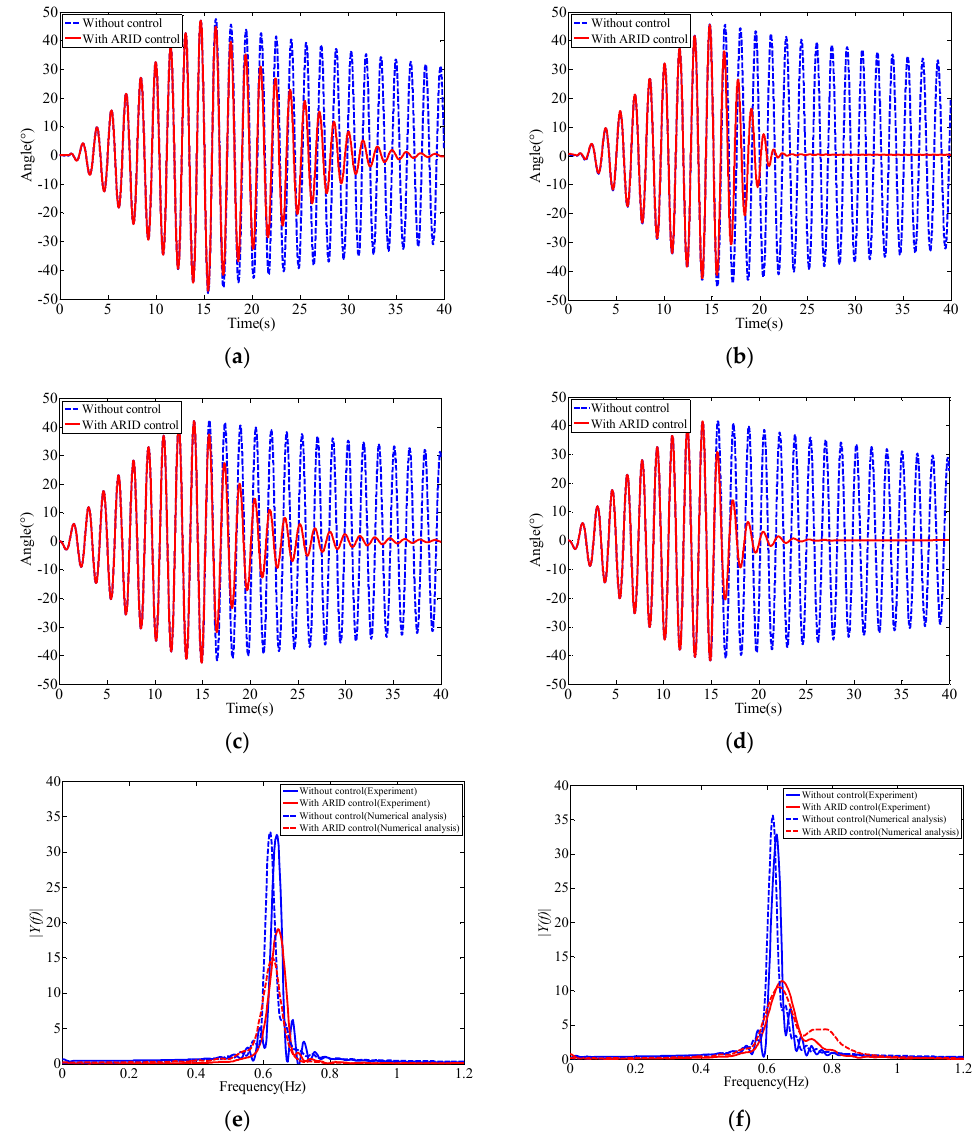
Figure 14. Comparison of experiment and numerical analysis results: ( a ) Experiment swing angle time history of No.1; ( b ) Experiment swing angle time history of No.3; ( c ) Numerical analysis swing angle time history of No.1; ( d ) Numerical analysis swing angle time history of No.3; ( e ) Amplitude-frequency curve of No.1; ( f ) Amplitude-frequency curve of No.3.